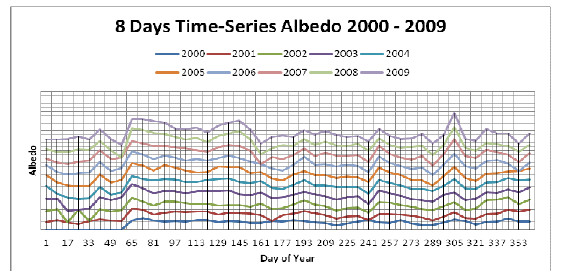
Figure 4. Daily Albedo 2000 - 2009 (stacked line)